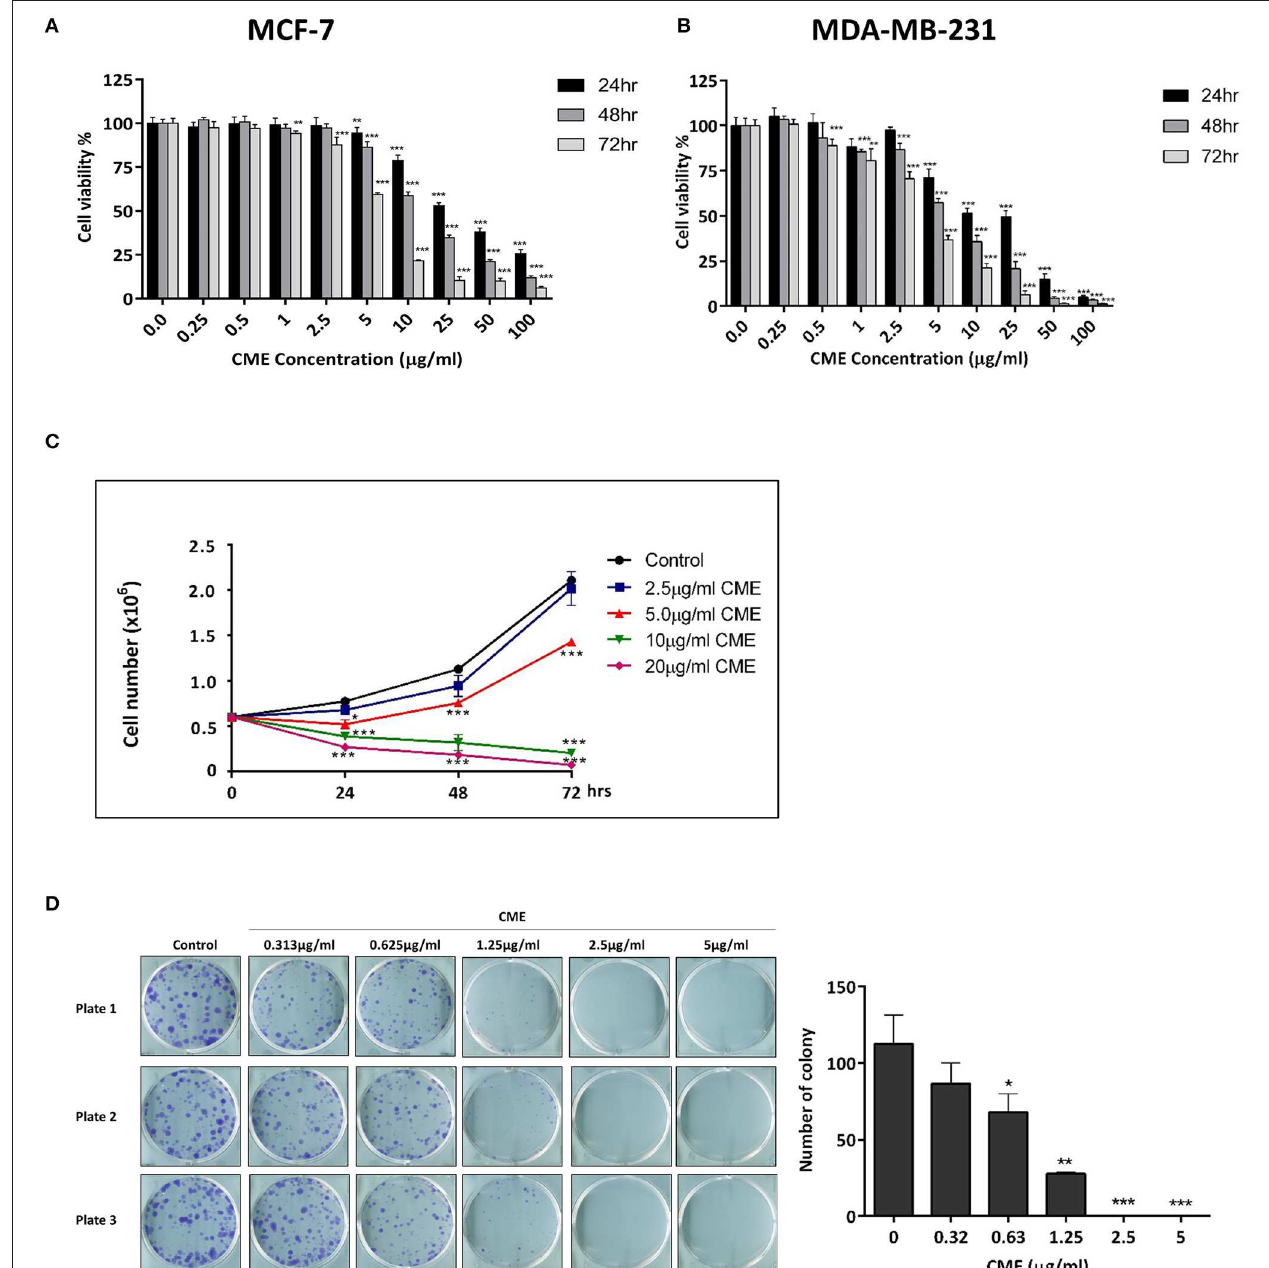
FIGURE 1 | CME time- and dose-dependently reduced cell viability, inhibited cell proliferation, and colony formation in breast cancer cells. Cell viability assay of (A) MCF-7 and (B) MDA-MB-231 cells. Cells were treated with CME at the indicated concentrations for 24, 48, and 72h. Cell viability was measured by MTT assay. (C) Cell proliferation assay of CME in MDA-MB-231 cells. Cells were treated with CME at the indicated concentrations for 24, 48, and 72h, after which viable cells were counted. (D) Clonogenic assay showing colony formation of MDA-MB-231 cells treated with the indicated concentrations of CME for 14-days. Data are presented as the means ± SD from three independent experiments. * P < 0.05, ** P < 0.01, and *** P < 0.001 vs.